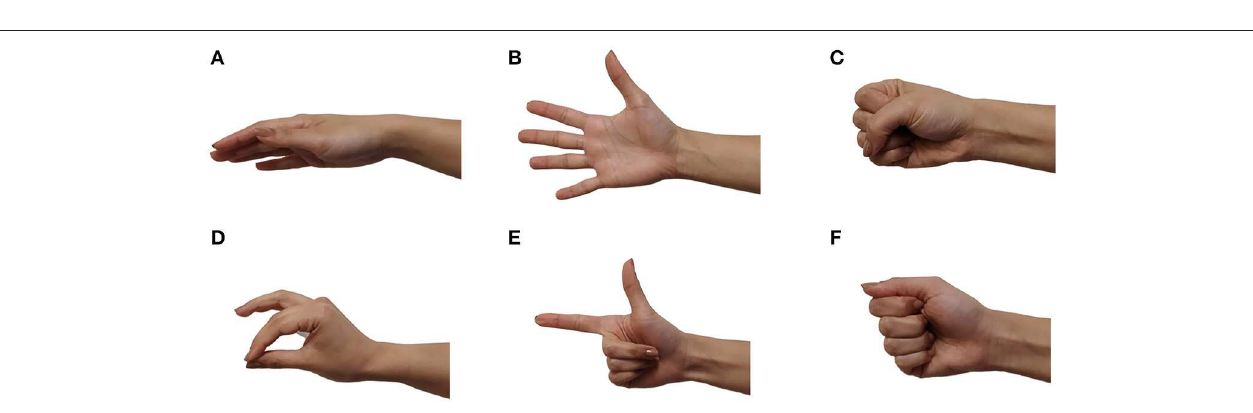
FIGURE 3 | The six grips used in this protocol: (A) relax, (B) open, (C) force, (D) tripod, (E) finger point, (F)